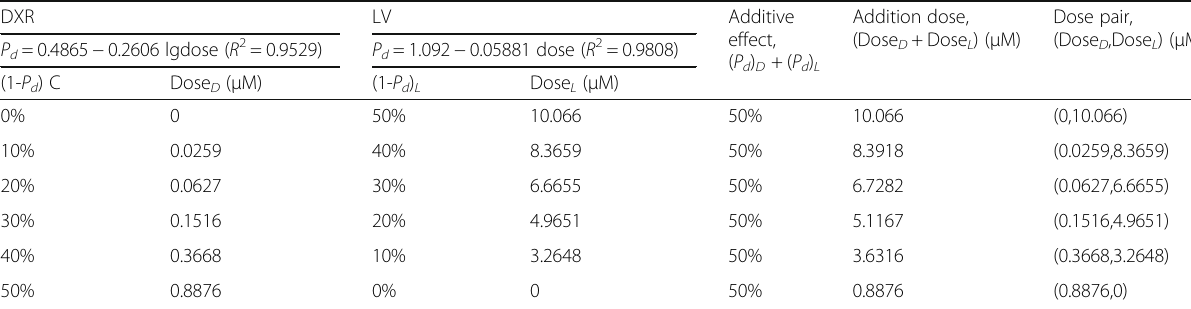
Table 1 Data for plotting the isobole DXR LV Additive